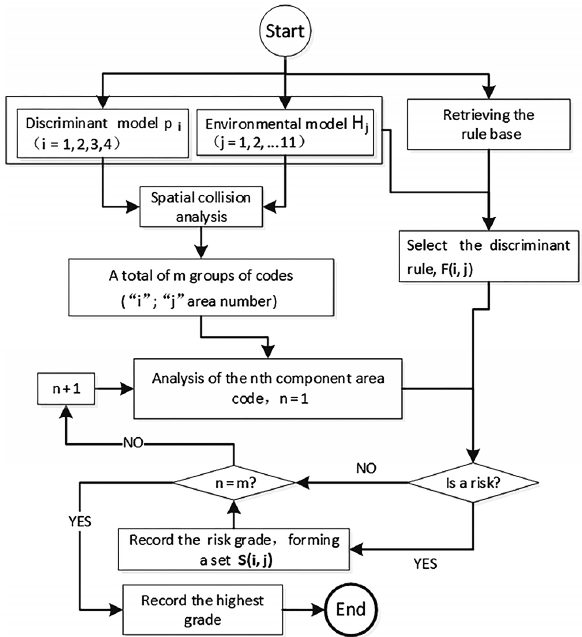
Figure 11. Algorithm environmental risk classification